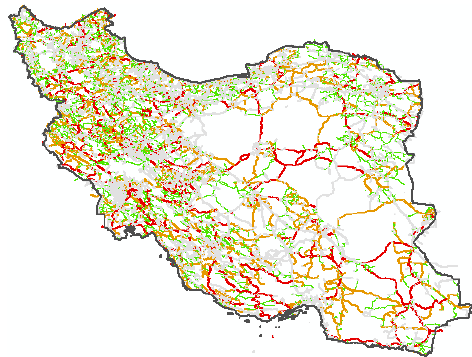
Figure 6. Traffic lines classification in Iran